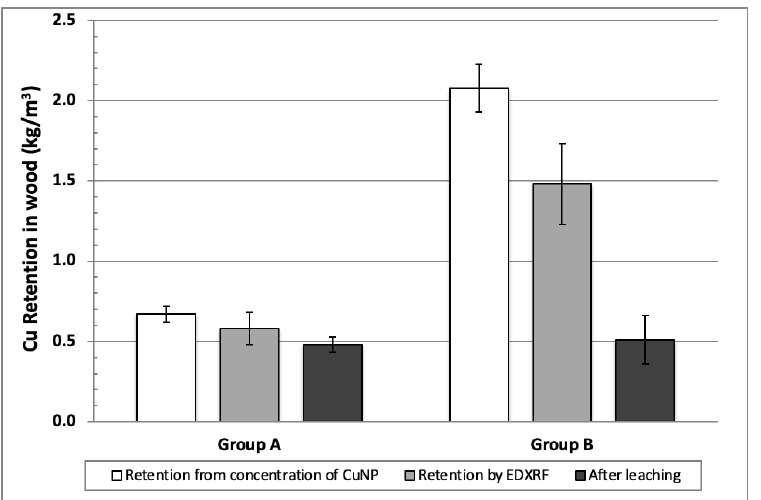
Figure 3. Copper retention in radiata pine wood impregnated with CuNPs. Group A woods were treated with a 1 g/L solution of CuNP and group B woods were treated with a 3 g/L solution of CuNP. White bars correspond to Cu retention in wood from the concentration of CuNPs in the solution, gray bars correspond to Cu retention in wood impregnated by EDXRF, and black bars correspond to Cu retention in wood leached by EDXRF.